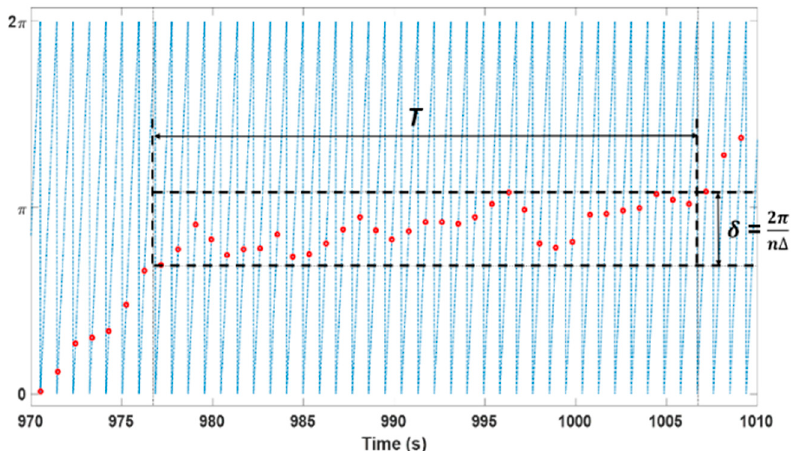
Figure 4. Phase synchronization and synchrogram method. Each R-peak location of the ECG (red dots) is placed at the corresponding location of the instantaneous phase on the stimulus (blue line). A synchronization epoch was determined for the segment where the variation in the points was maintained within δ = 2 π / ( n ∆ ) and prolonged for T seconds. n , ∆ and T were set to 1, 5 and 30, respectively. ECG—electrocardiogram.